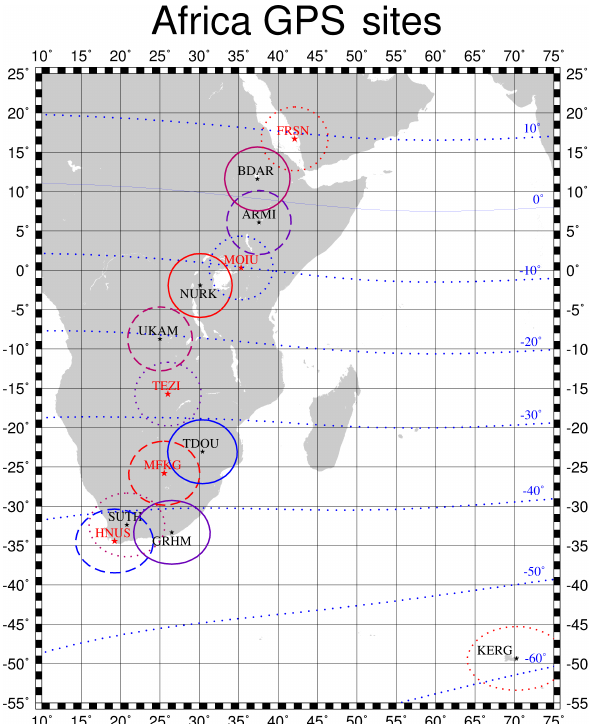
Figure 1. The GPS stations used for the Africa TEC profile for day 205, 2011, with their associated ionosphere coverage regions (ovals), corresponding to an elevation threshold of 35 ◦ and an iono- sphere altitude of 350km. Geomagnetic latitudes are shown in blue, and stations for which SUPIM values were calculated are shown in red text.